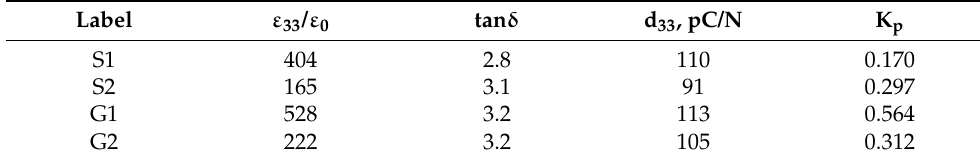
Table 3. Piezoelectric properties of TPMS